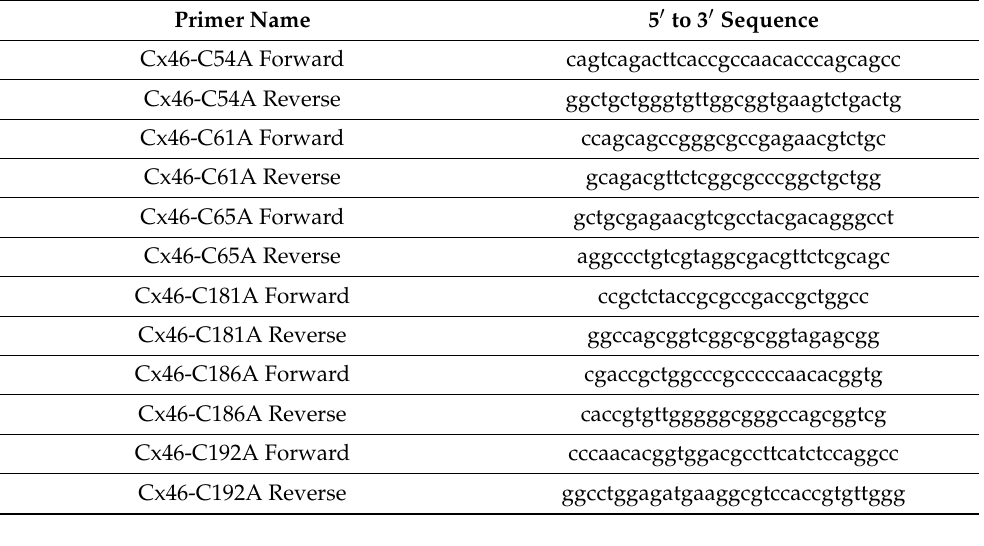
Table 1. Site-directed mutagenesis primers for hCx46 extracellular Cys mutations.